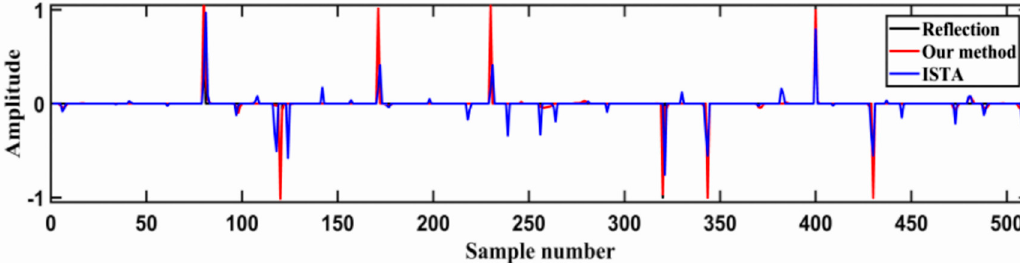
Figure 10. Comparison of the deconvolution results obtained from the trial noisy seismogram by the algorithm proposed in this study (red spikes) and conventional ISTA (blue spikes).